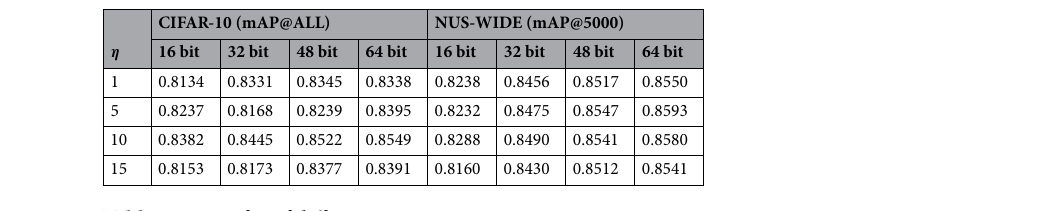
Table 4. mAP for of different η